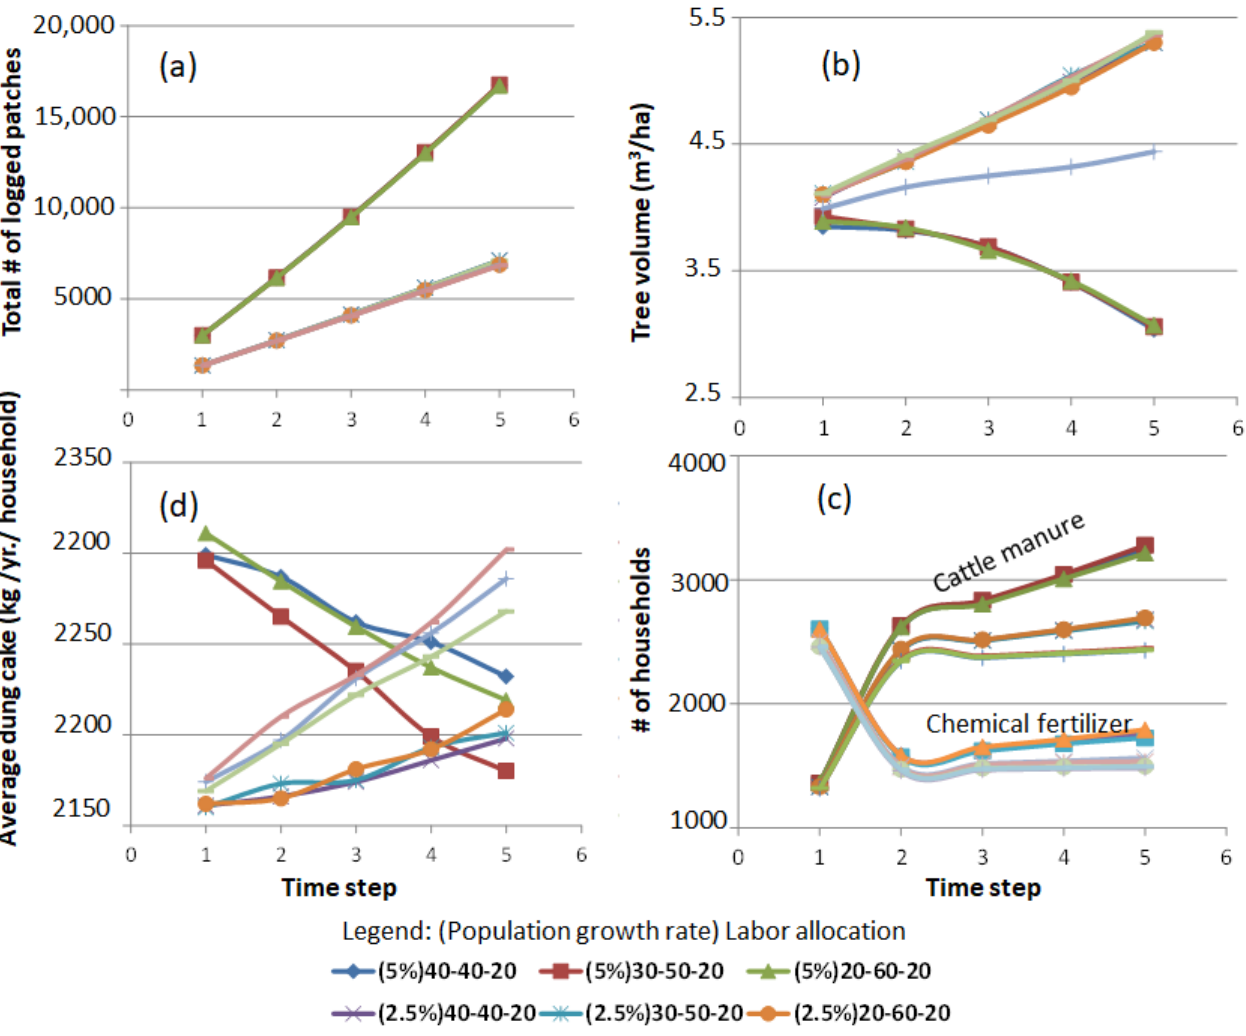
Figure 2. Patterns of logged tree patches ( a ), tree volume per hectare ( b ), number of households using organic (cattle dung) and chemical fertilizers ( c ), and mean amount of cattle dung collected ( d ) per household under different labor allocations and population growth scenarios .